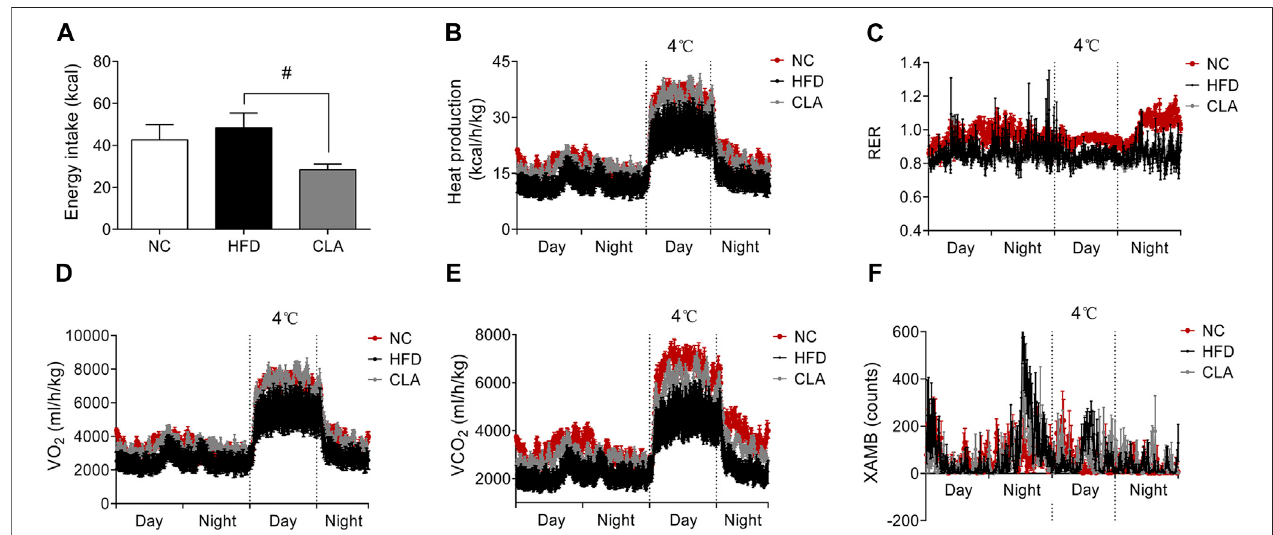
FIGURE 2 | Effects of CLA on the whole-body energy metabolism of mice given a HFD for 16w. Mice were caged individually for 48 h the energy intake (A) , heat production (B) , respiratory exchange rate (RER) (C) , oxygen production (VO 2 ) (D) , carbon dioxide production (VCO 2 ) (E) , and X -axis ambulatory (XAMB) value (F) of the mice were monitored by a Promethion metabolic cage system (Sable Systems, Las Vegas, NV). Data are shown as the mean ± SEM ( n (cid:2) 5). # p < 0.05, vs.